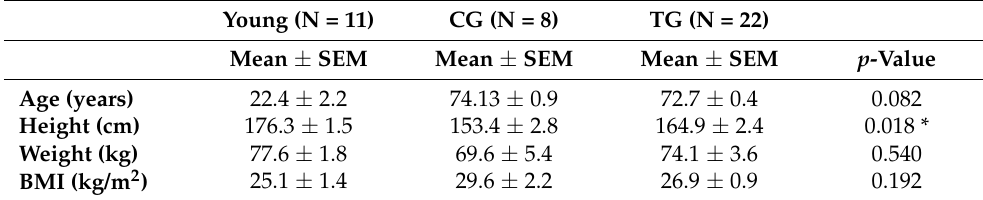
Table 1. Participant anthropometric